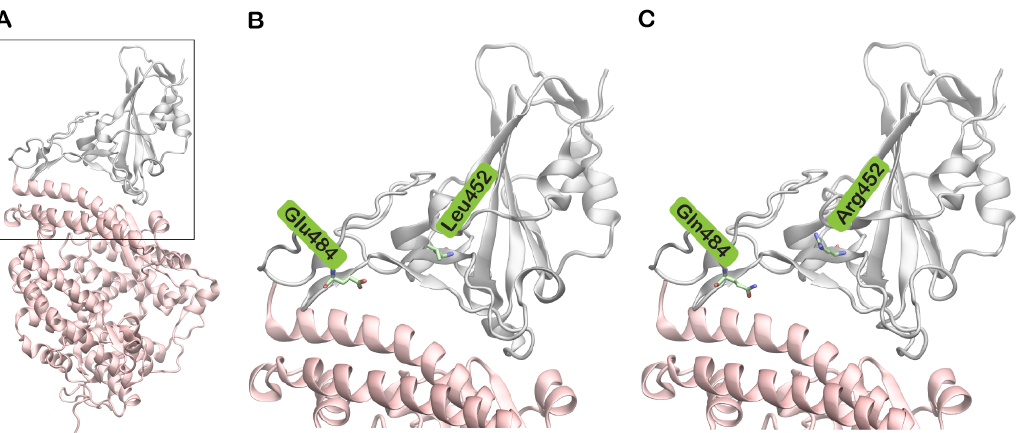
Figure 1. Structures of SARS-CoV-2 spike (S) protein receptor-binding domain (RBD) bound to human ACE2 (hACE2). ( A ) SARS-CoV-2 S protein RBD (grey) bound to hACE2 (pink) based on Protein Data Bank (PDB) structure with PDB ID: 6M0J; ( B ) The boxed region in A is enlarged showing the wild type residues Leu452 and Glu484 in stick representation. ( C ) The boxed region in A is enlarged showing the mutated residues Arg452 and Gln484.